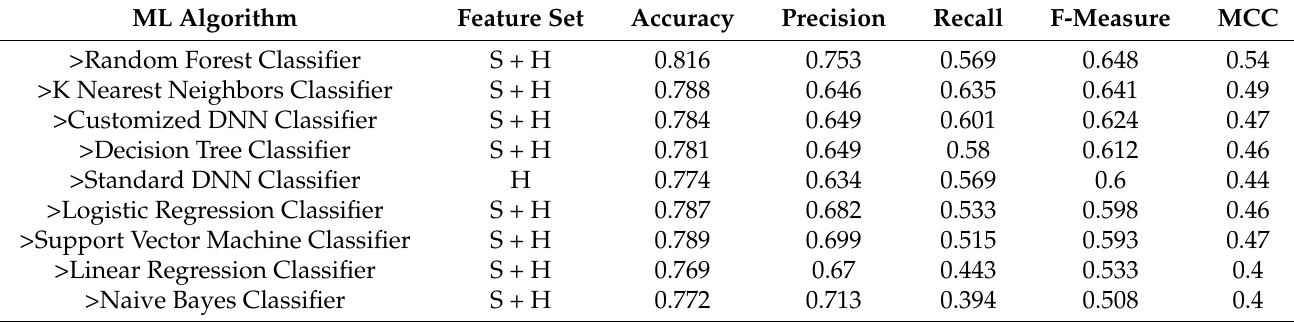
Table 3. The best results of the nine ML algorithms according to their